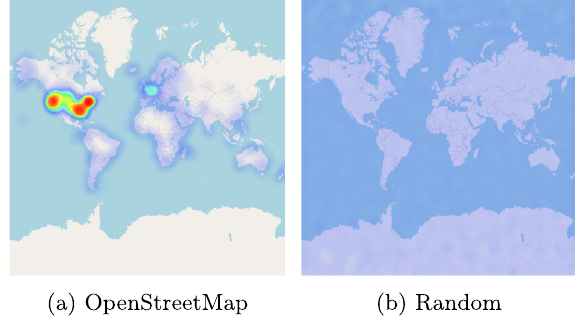
Fig. 7 Heatmap of the two datasets, coordinates range from [− 180 ◦ , − 90 ◦ ] to [ 180 ◦ ,90 ◦